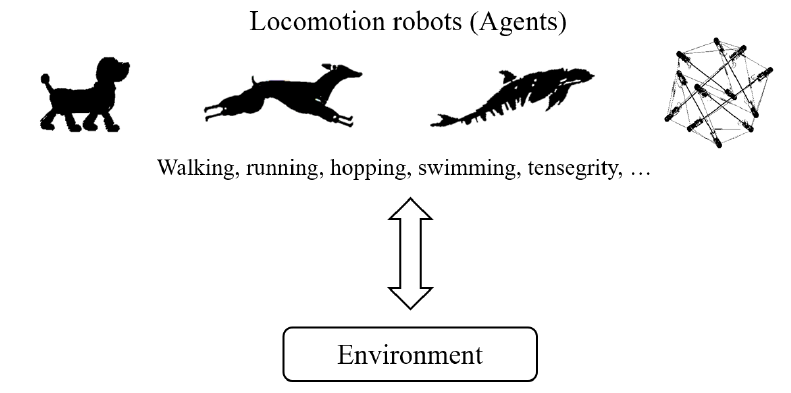
Figure 6. Locomotion